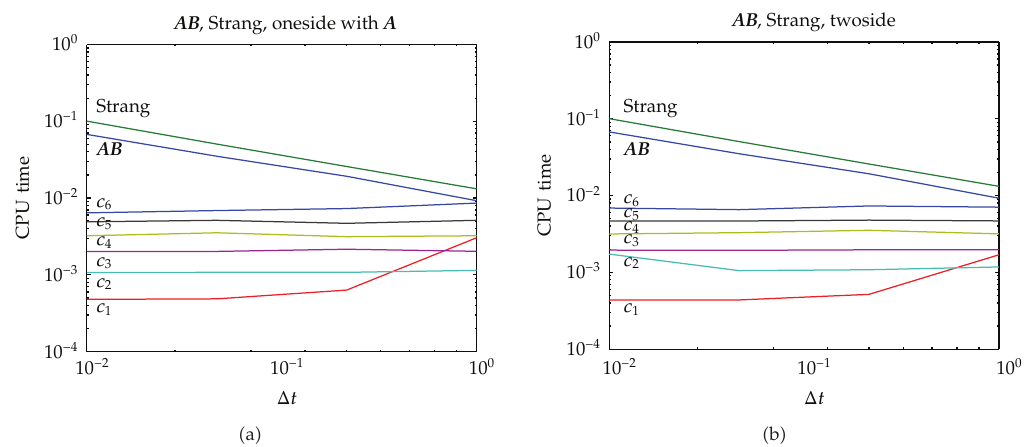
Figure 9: CPU time of the one-side splitting scheme with A (cid:5) a (cid:6) and the iterative schemes with 1 ,... , 6 iterative steps (cid:5) b (cid:6)